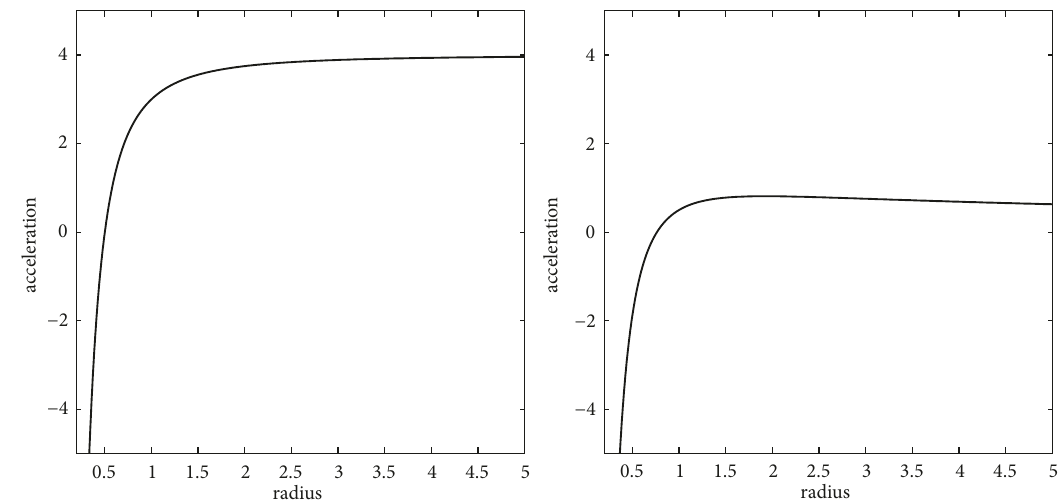
Figure 6: The left panel shows a case where the acceleration of the universe approaches a constant value and the right panel shows a case where the acceleration slowly approaches zero for 𝑡 󳨀→ ∞ . The figures are taken from [12, 34].